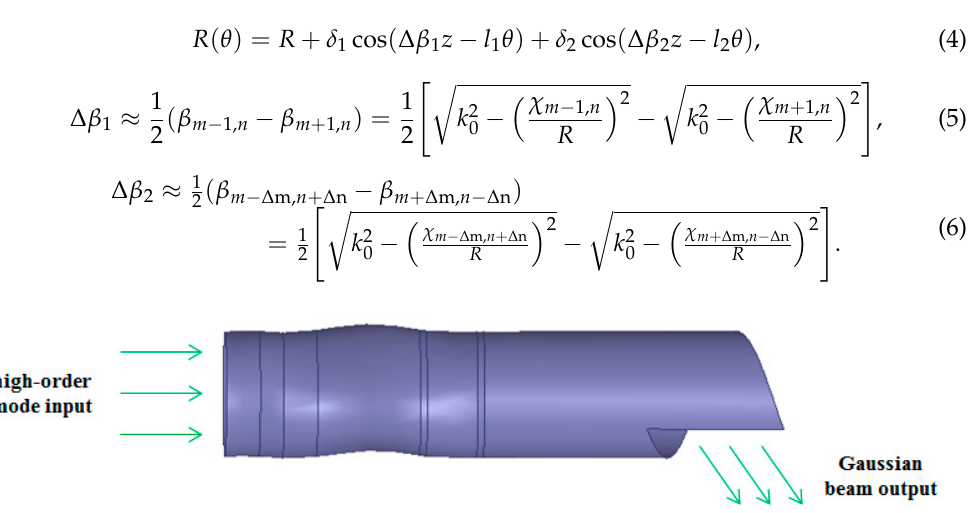
Figure 9. Schematic drawing of TE 25,10 Denisov-type launcher (the radius is increased by 20 times). = 1 and 𝑙 = 3 , z is the axial coordinate, and 𝜃 is the an- In Equations (4)–(6), 𝑙 (cid:2869) (cid:2870) = 0.04𝑚𝑚 and 𝛿 = 0.06 𝑚𝑚 are the amplitudes of launcher de- gular coordinate; 𝛿 (cid:2869) (cid:2870)